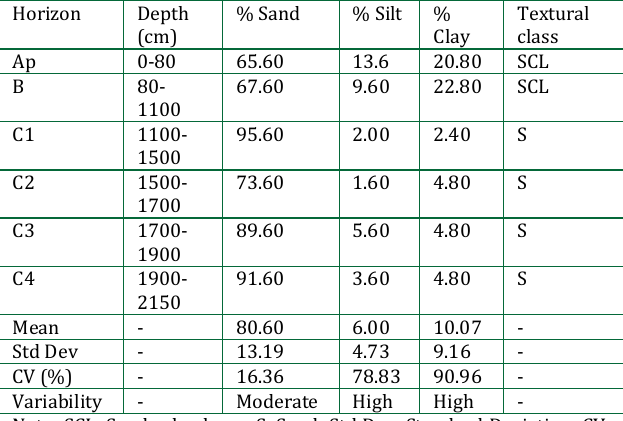
- Moderate High Coefficient of